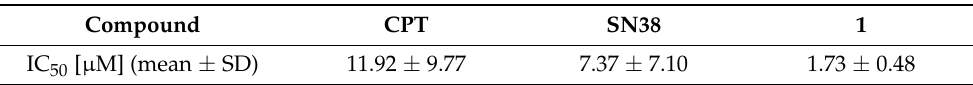
Table 10. The IC 50 indices—a concentration required to reduce the relaxation Topo I activity by 50%. Values are presented as mean ± SD ( n =